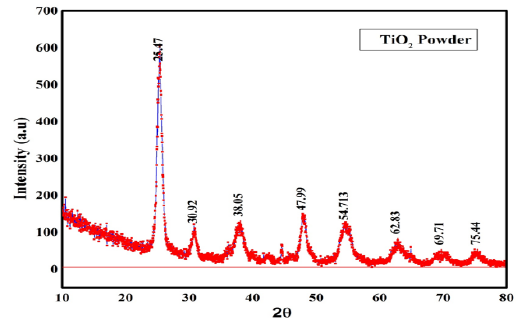
Fig. 1. X-ray diffraction profiles of (a) pure TiO